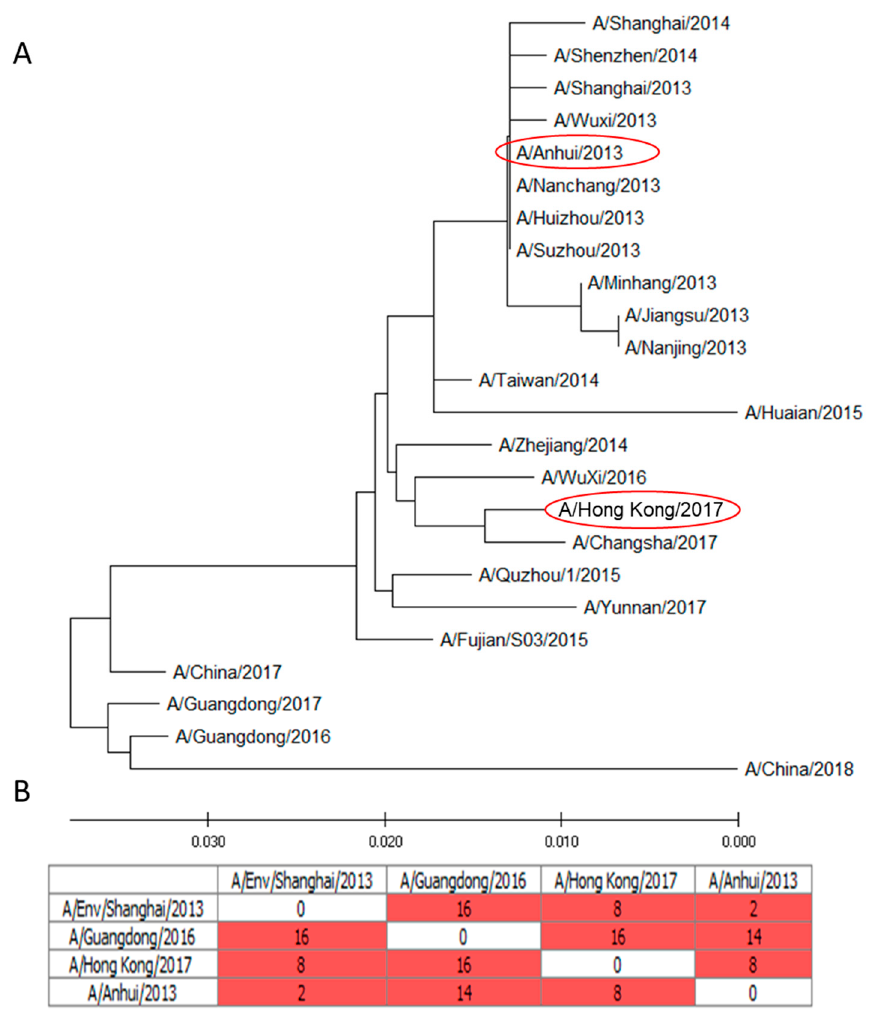
Figure 1. Evolutionary analysis of NA A/H7N9 viruses. ( A ) Phylogenetic tree of 24 amino acid sequences of influenza A/H7N9 viruses. The optimal tree with the sum of branch lengths = 0.15418388 is shown. The tree is drawn to scale, with branch lengths having the same units as those of the evolutionary distances used to infer the phylogenetic tree. The evolutionary distances were computed using the Poisson correction method [10] and are in the units of the number of amino acid substitutions per site. This analysis involved 41 amino acid sequences. All ambiguous posi- tions were removed for each sequence pair (pairwise deletion option). There was a total of 465 po- sitions in the final dataset. Vaccine strains are marked on philodendrogram. ( B ) Multiple sequence alignment distance matrix of the NA of viruses used in the study. The matrix demonstrates the number of amino acid substitutions between influenza virus strains. The multiple alignment of the amino acid sequences of the N9 viruses showed that the NA of A/Anhui/1/2013(H7N9) and A/Hong Kong/125/2017(H7N9) LAIV viruses dif- fered by 8 amino acid substitutions (Figure 1B): (I16 Т ), (M72I), (Y166H), (V236A), (S242P), (I300V), (N322S), (A365T). We developed two A/H6N9 recombinant viruses in order to avoid non-specific re- action with antibodies to HA when analyzing neuraminidase inhibiting (NI) antibodies to A/H7N9 viruses. It was shown that the NA of A/Anhui/1/2013(H7N9) and A/Hong Kong/125/2017(H7N9) in recombinant A/H6N9 viruses differ in enzymatic activity with large molecular substrate fetuin (molecular weight, 50,000 [11]) (Figure 2). This follows from the differences in the optical density of wells containing NA desialyzed fetuin sites (Figure 2). The activity of the NA from the A/Hong Kong/125/2017(H7N9) virus was ap- proximately two times higher compared to NA of A/Anhui/1/2013(H7N9). This circum-